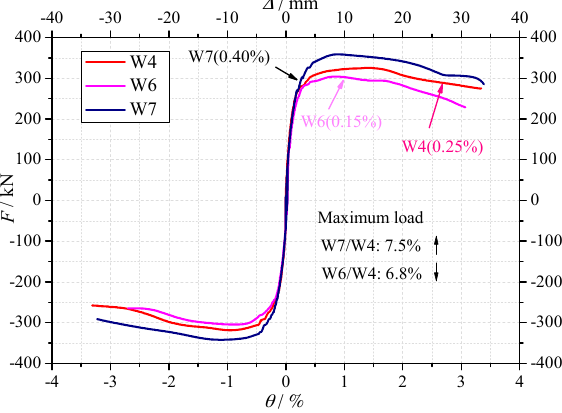
Figure 12. The skeleton curves of the specimens W4, W6 and W7.